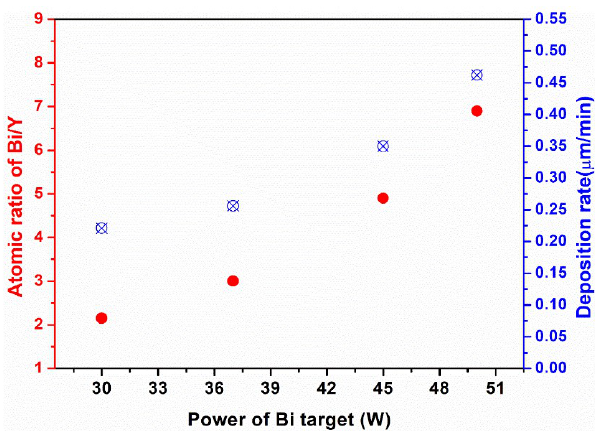
Figure 2. The atomic ratio of Bi to Y and the deposition rate of the films as a function of the power of the Bi target.